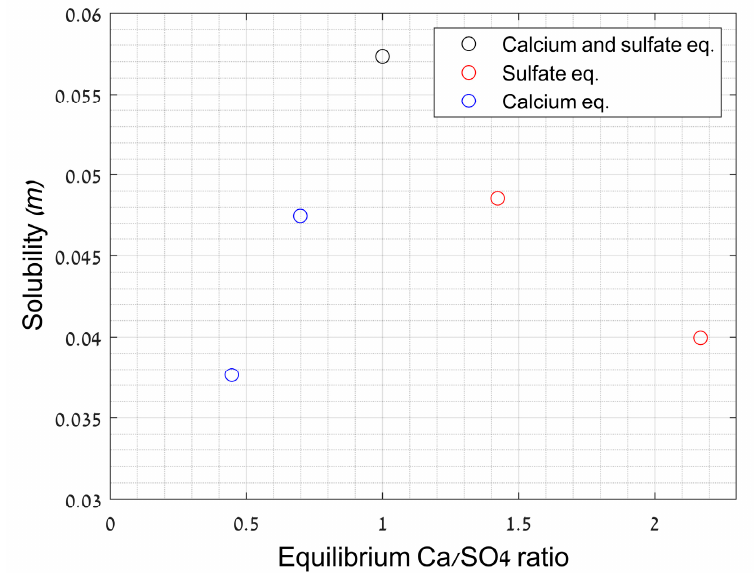
Figure 4. Calculated equilibrium concentration (eq.) of sulfate and calcium ( m ) in non-stoichiometric NaCl solutions ( I = 3 m ). If the ratio between the ions in solutions differs from that of the mineral, a relative larger amount of the less abundant ion would be incorporated into the mineral during precipitation. The ratio between the lattice ions at equilibrium is 0.45, 0.70, 1, 1.42, and 2.17. Note that for Ca 2+ /SO 42 − < 1 solubility is defined by the Ca 2+ concentration whereas for Ca 2+ /SO 42 − > 1 solubility is defined by the SO 42 − concentration.